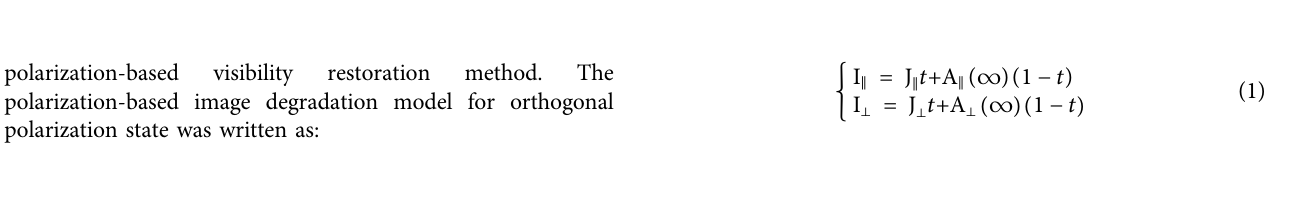
Frontiers in Physics |